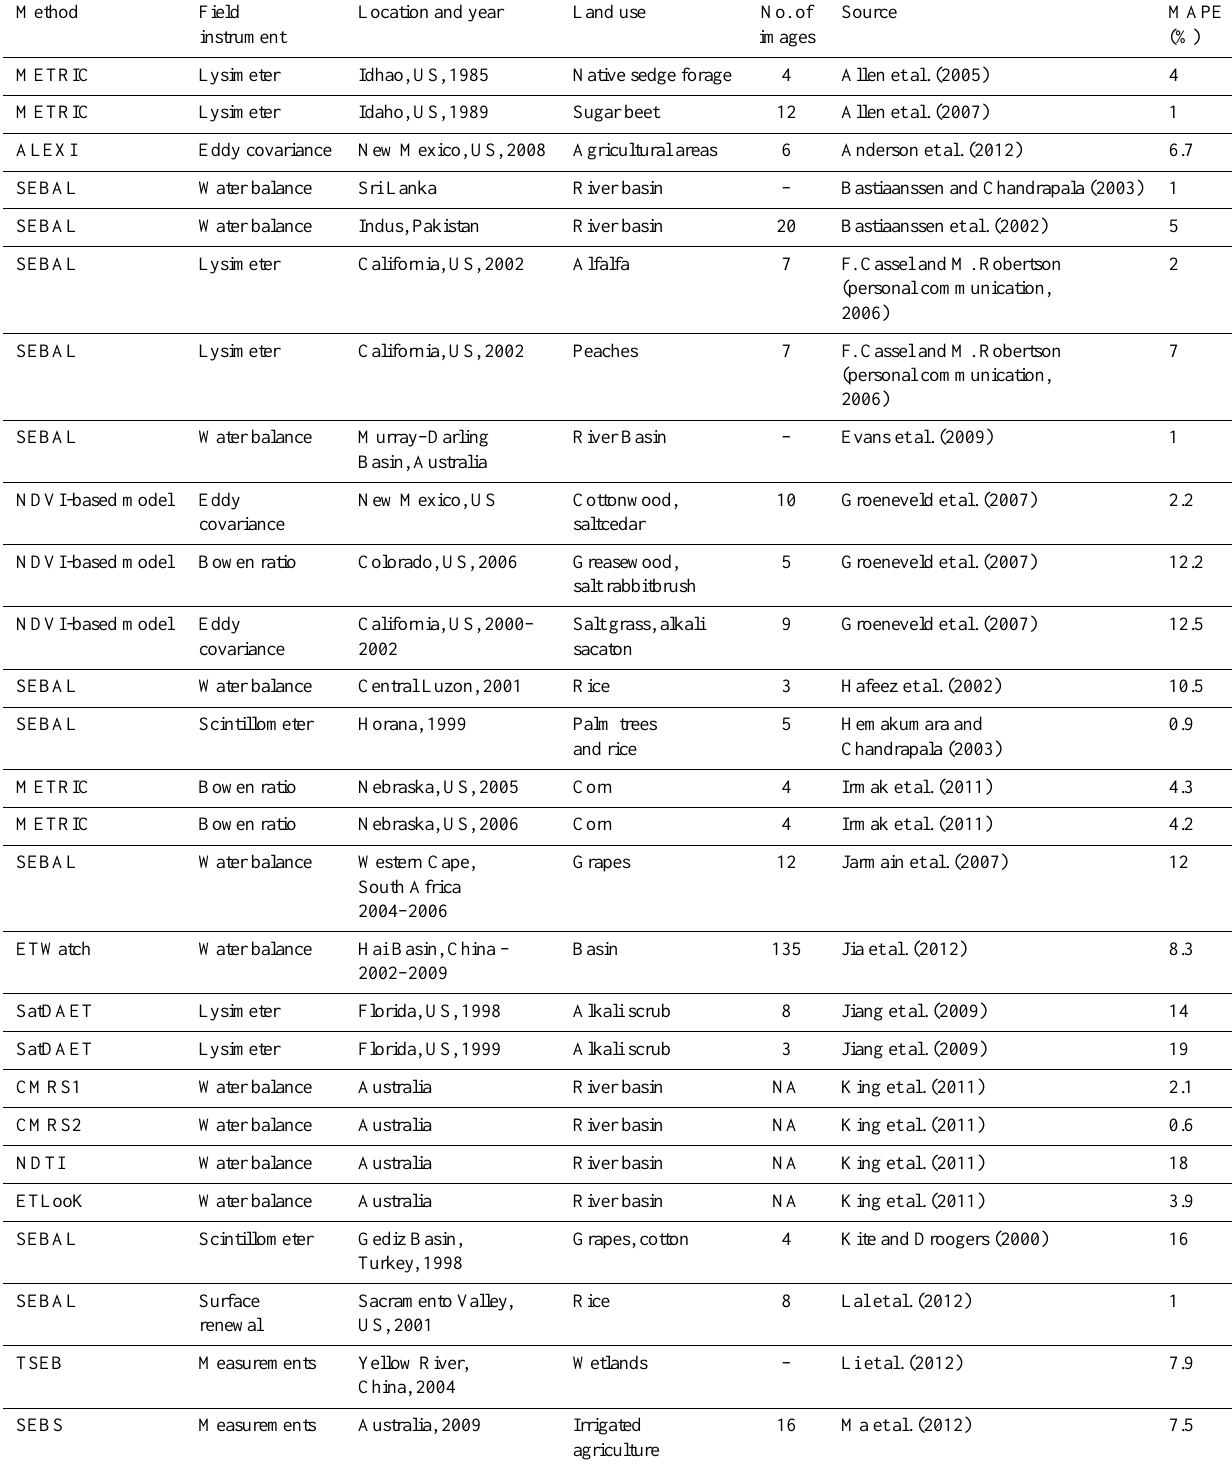
Table A1. Selected ET validation papers that describe experimental data sets covering a season or